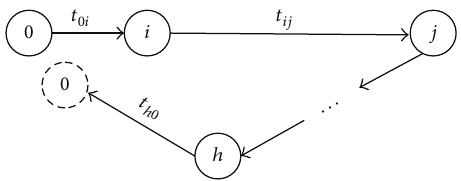
Figure 1: A network representation of the transportation